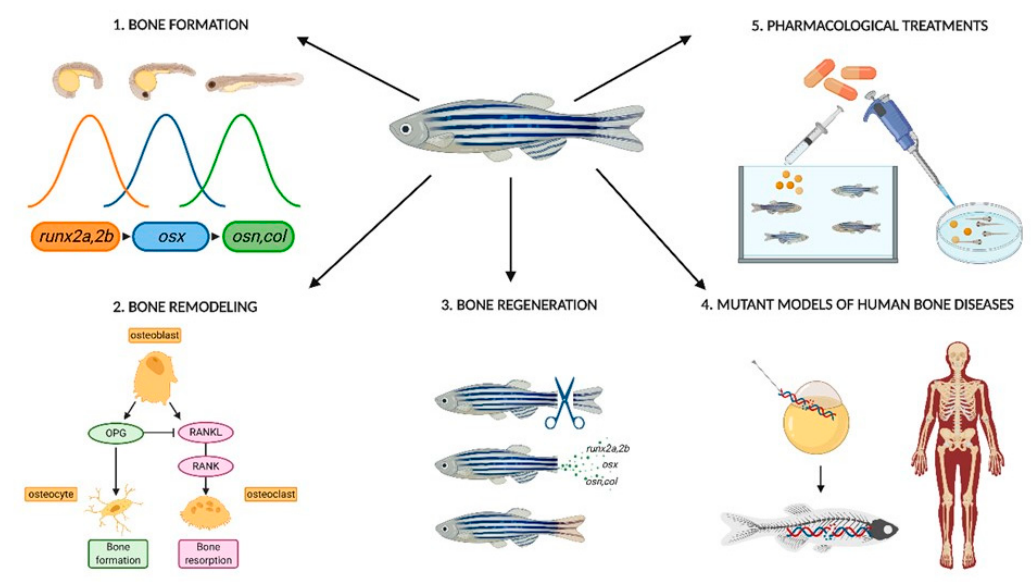
Figure 1. Zebrafish is a suitable tool for the study of cell signaling in bone, starting from the bone formation mechanism which recapitulates mammals molecular pattern involving orthologous genes runx2a/runx2b, osterix (osx) and downstream genes coding for bone matrix proteins (e.g., osteonectin